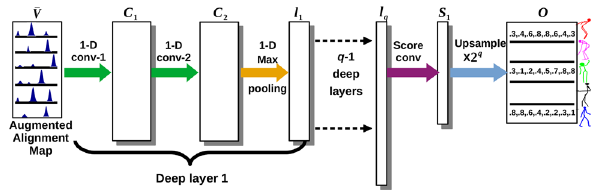
Fig. 5 Architecture of the 1D-CNN unit in the DACNN framework. It maps the augmented alignment map 𝐎